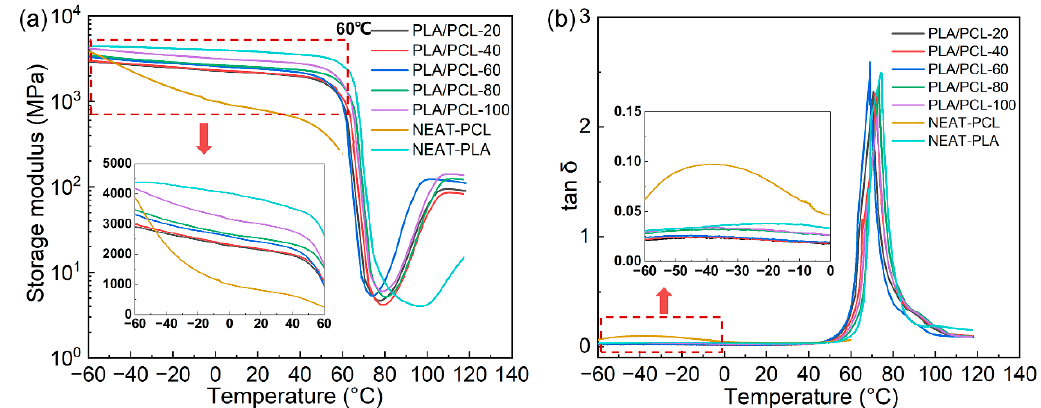
Figure 4. DMA curves of ( a ) storage modulus and ( b ) tan δ vs. temperatures.